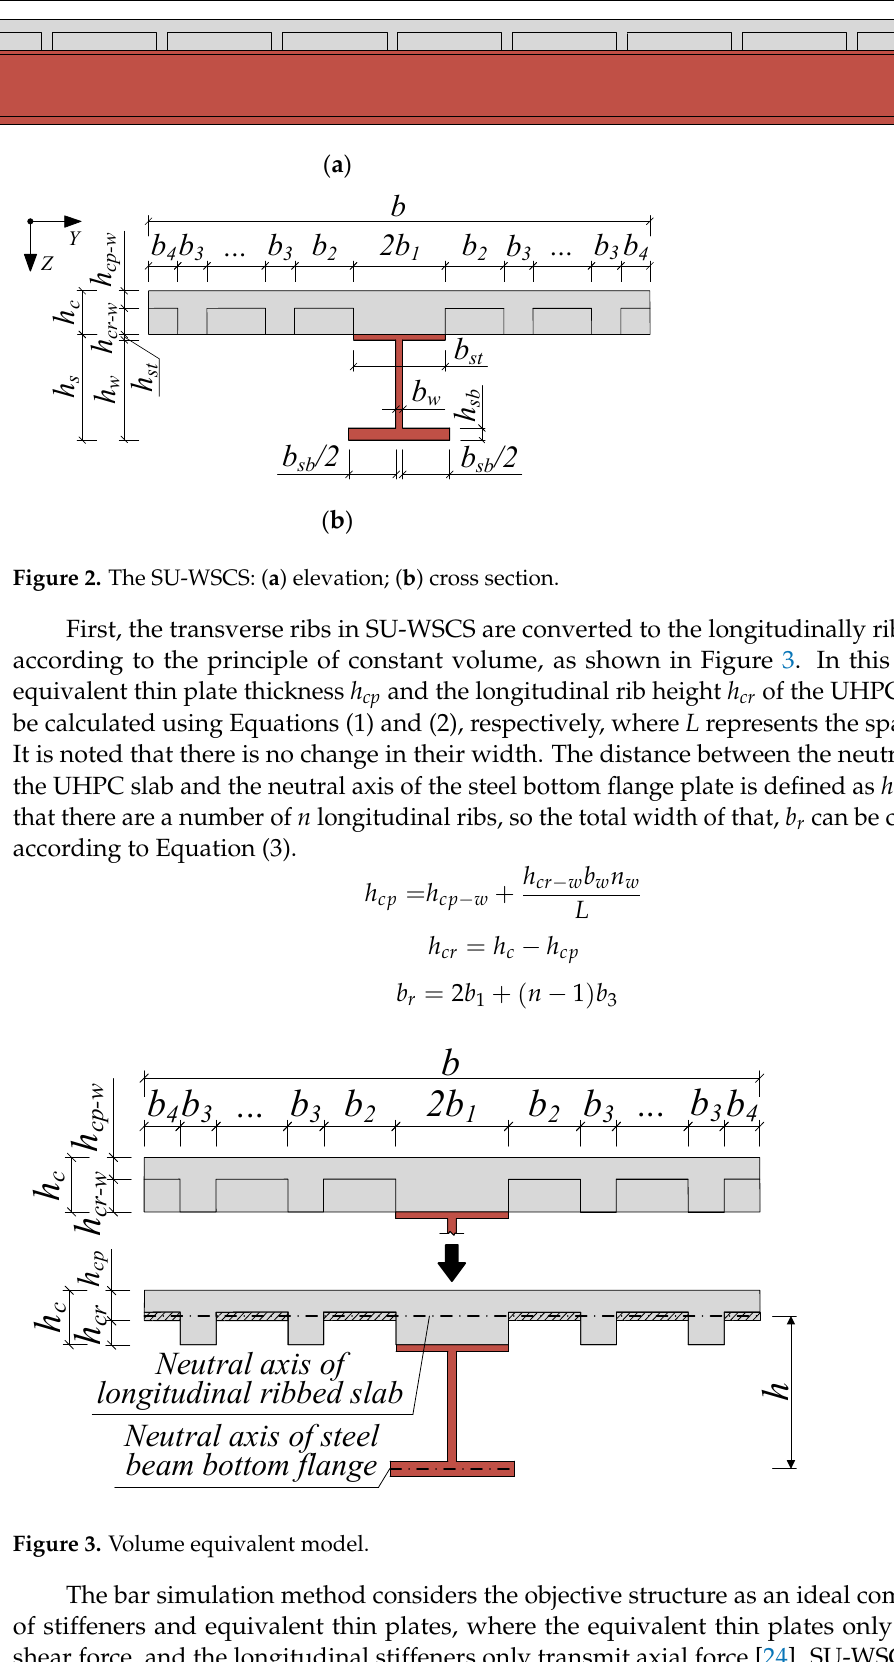
Figure 2. The SU-WSCS: ( a ) elevation; ( b ) cross section.